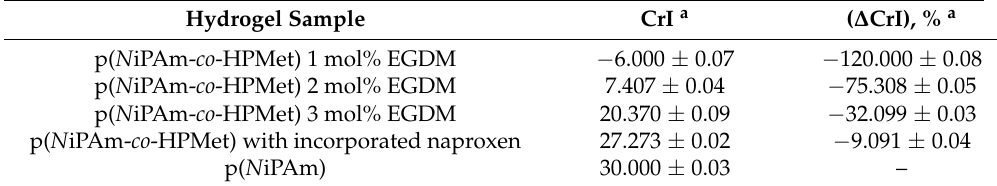
Table 5. The Values of The X-ray Crystallinity Index, CrI, and the Variations in the Crystallinity index, Δ (CrI) of Co-Hydrogels before and after Naproxen Incorporation.